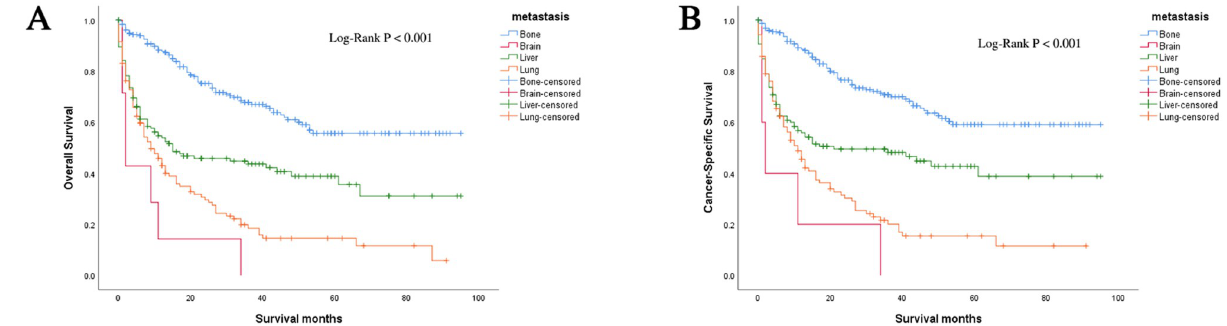
Fig 3. Kaplan-Meier curves and log-rank test for OS and CSS according to the site of metastasis (only one site). Patients in bone metastasis had the best survival outcomes in OS and CSS. Brain metastasis had significantly shorter OS and CSS compared with other types of sites; (a) OS; (b) CSS; OS, overall survival; CSS, cancer-specific survival; HR, hazard ratio; CI, confidence